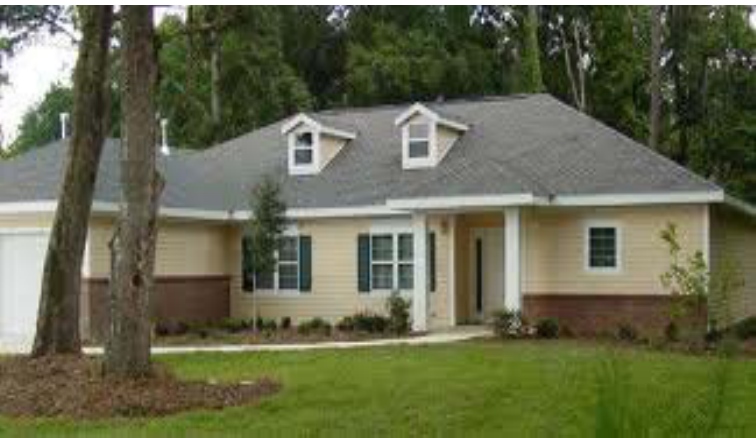
Figure 6. Gator Tech smart house (Courtesy: Gator